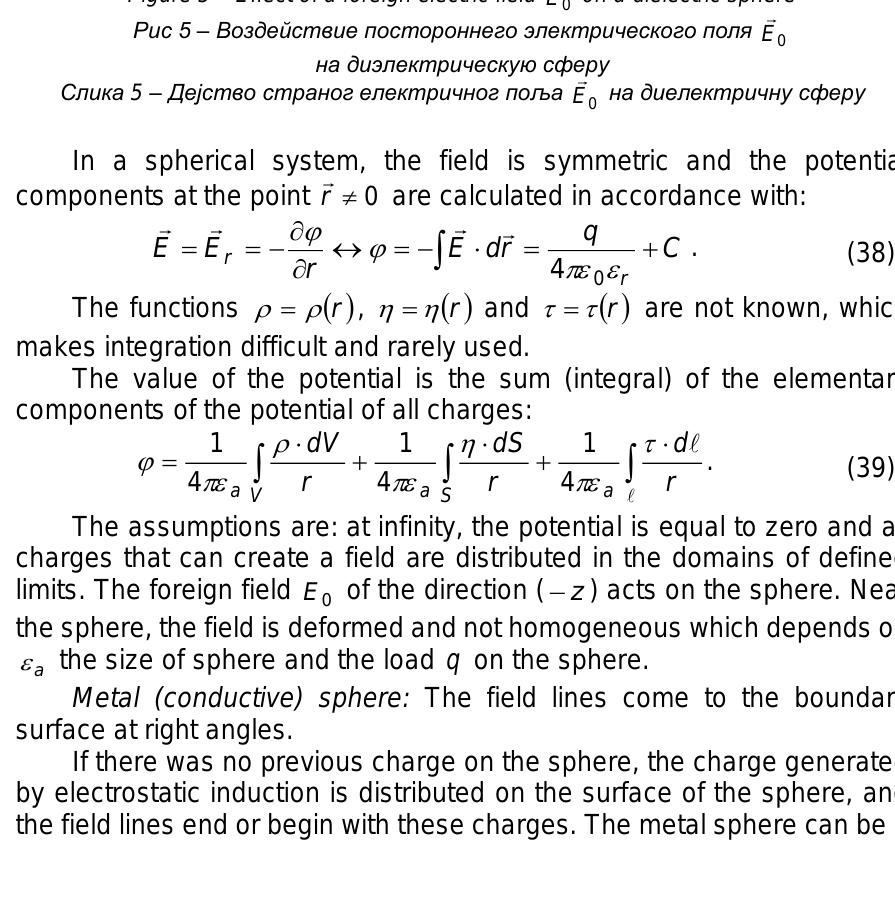
 on a dielectric sphere E 0